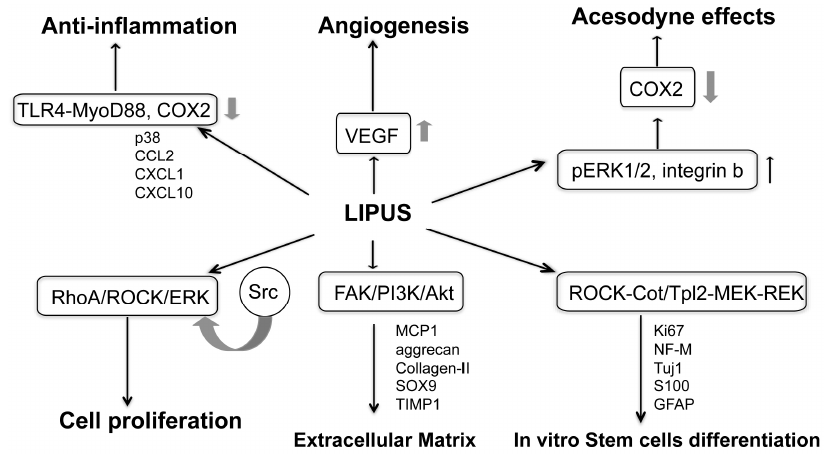
Figure 1. Biological and molecular mechanisms of Low-intensity pulsed ultrasound (LIPUS) for the therapy of chronic prostatitis/chronic pelvic pain syndrome (CP/CPPS). Upward arrow: increase; Downward arrow: decrease.